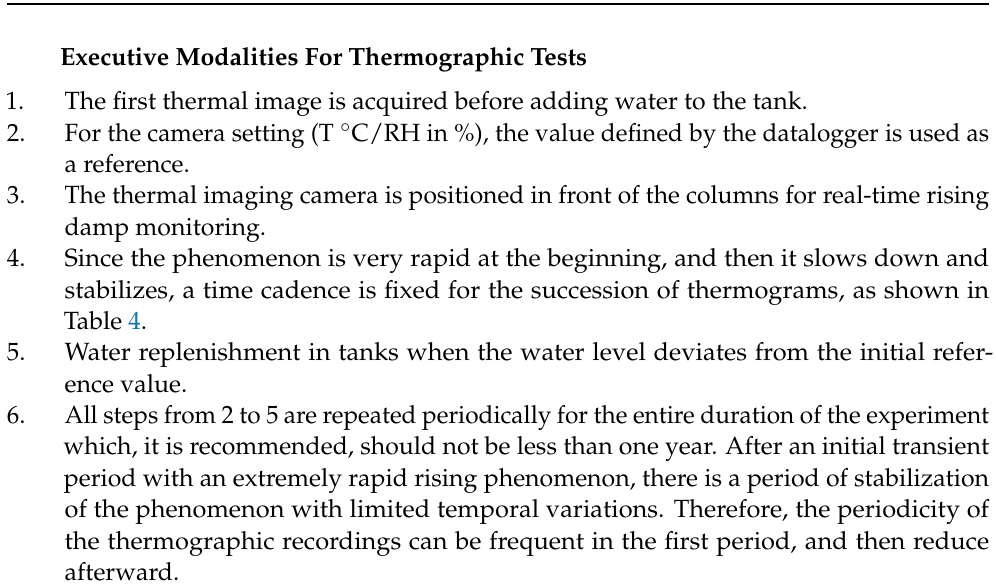
Table 4. Time frame for weighing steps, thermography (IR) and wetting tests. Day Time Weighing Ir